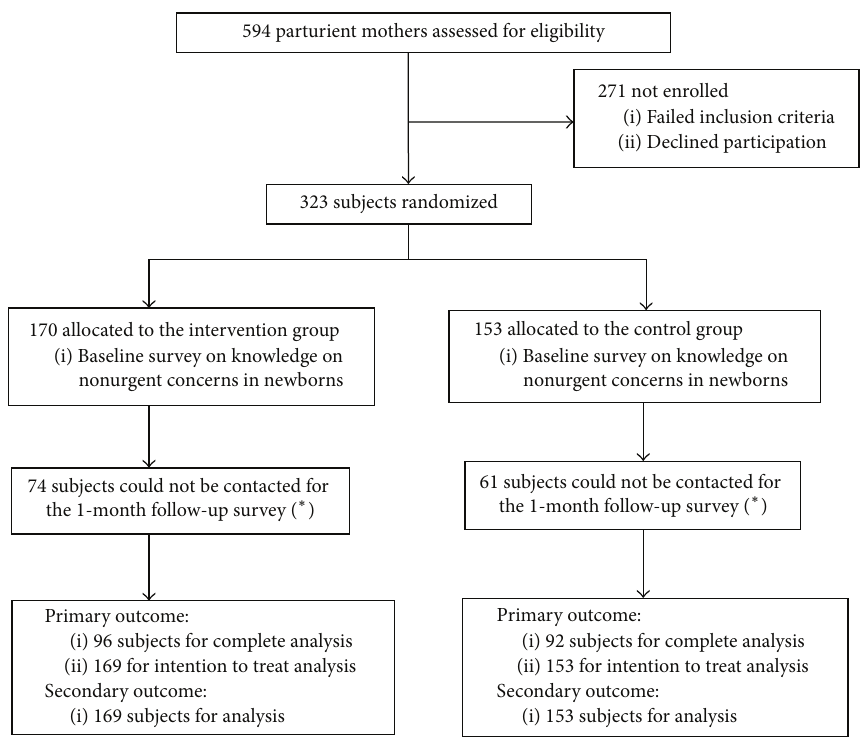
Figure 1: Enrollment flow